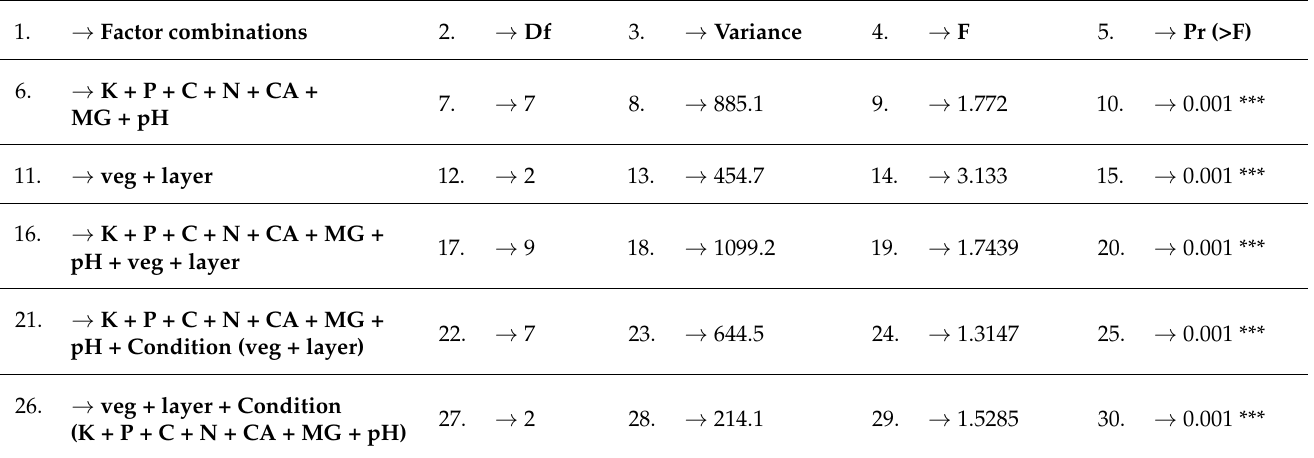
Table 1. Indicator analysis figured out the factors combine to explain the variations of fungal communities. *** means p < 0.001 (Duncan Multiple Range